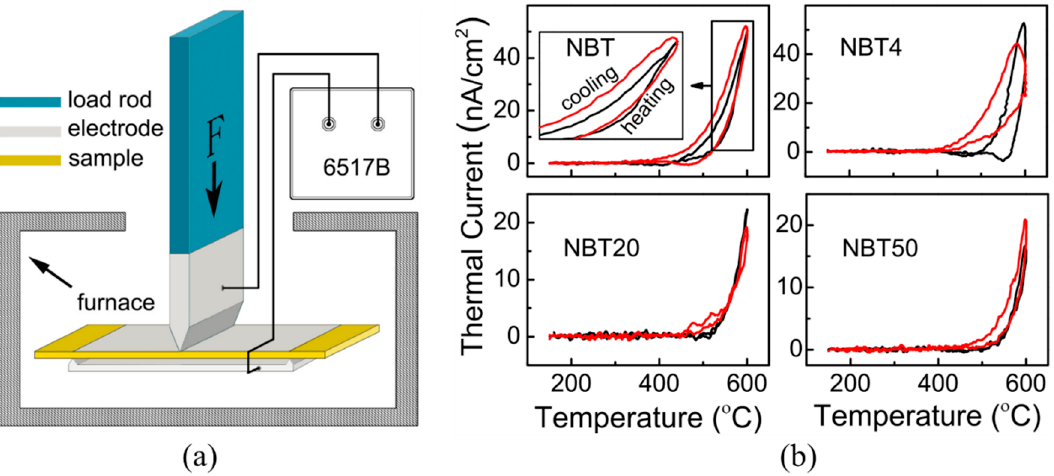
Figure 22. ( a ) Schematic of the thermal current measurements under the application of a three-point bending load to the samples. ( b ) The temperature dependence of the thermal current density of BNT- based ceramic plates using the test device in ( a ). The red curves are the measured results after flipping the samples. The current direction is mainly dependent on the direction of the strain gradient, which is less related to the direction of the heat transfer. Reprinted with permission from [106]. Copyright 2018 American Physical Society.